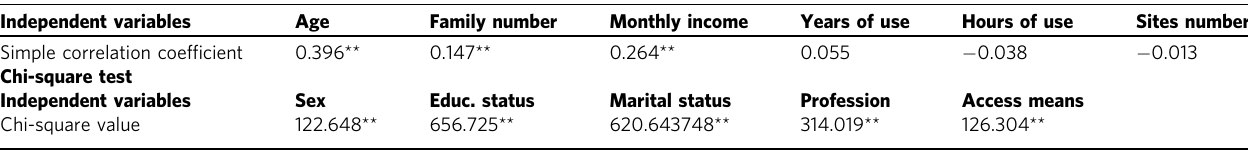
Table 10 Values of the simple correlation coef fi cient and Chi-Square test between each of the studied independent variables of the respondents and the degree of their cultural